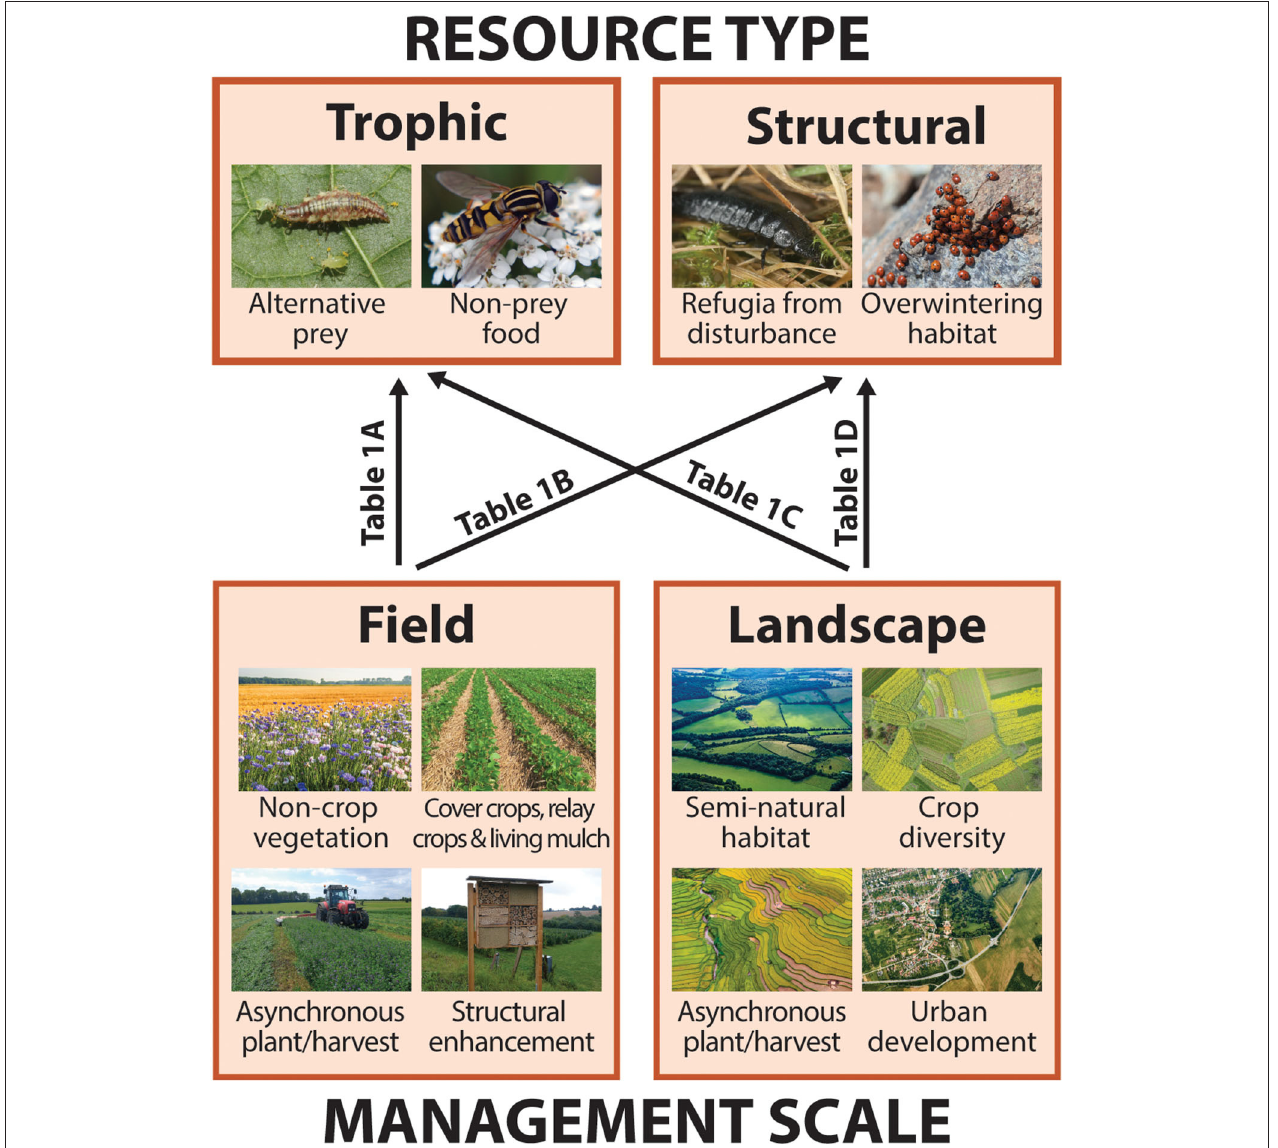
FIGURE 2 | Graphical schematic of the relationships between key natural enemy resources and habitat features that may contribute to their continuity or discontinuity at two management scales (described in section Conceptual Framework: Defining Resources, Continuity, and Scale). Boxes correspond to subsequent sections detailing how and in what instances different resource types, trophic (i.e., food) or structural (i.e., shelter), may be important for natural enemies (section Resources for Natural Enemies: Trophic and Structural), and management features that contribute to resource continuity both within-fields and across agricultural landscapes (section Creating Continuity: Habitat Features in Fields and Landscapes). Arrow labels refer to rows in Table 1 listing examples of studies that describe each of four scale-by-resource interactions. Photos via Shutterstock, standard